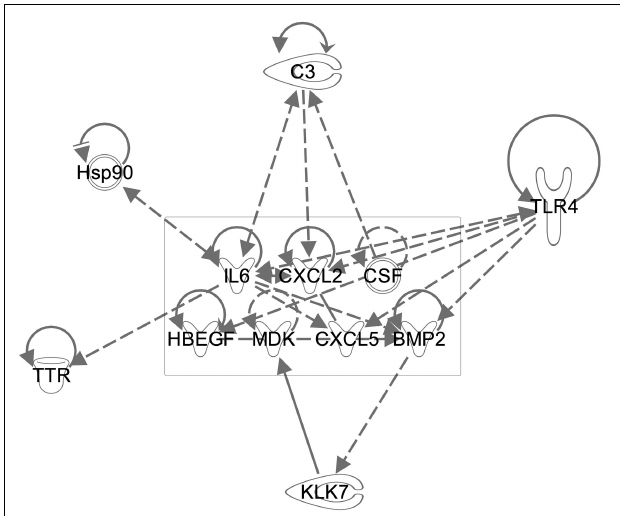
FIGURE 10 | The known WJC secretome regulates multiple genes found to be altered after sound trauma and MSC delivery. Components of the WJC secretome (boxed area) were evaluated for potential interactions with genes that we found to undergo significant change using the IPA knowledgebase. This demonstrates the potential biological basis for the protective effects that WJCs have on noise